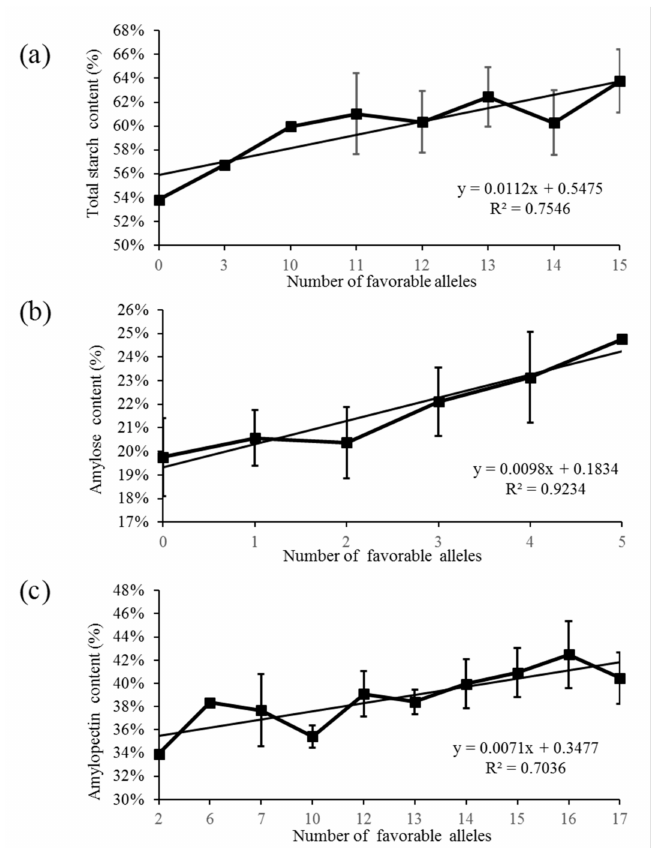
Figure 5. Linear regression analysis for the number of favorable alleles and starch content. ( a ), total starch content; ( b ), amylose content; ( c ), amylopectin